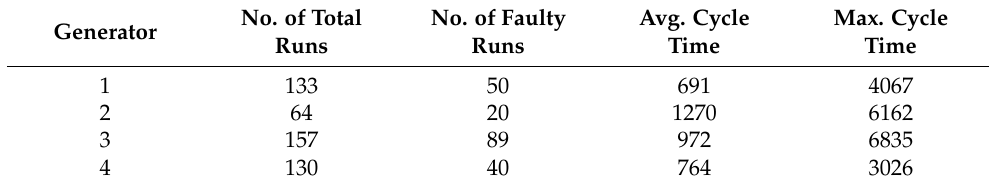
Table 1. Descriptive information of the runs by generators contained in the dataset.